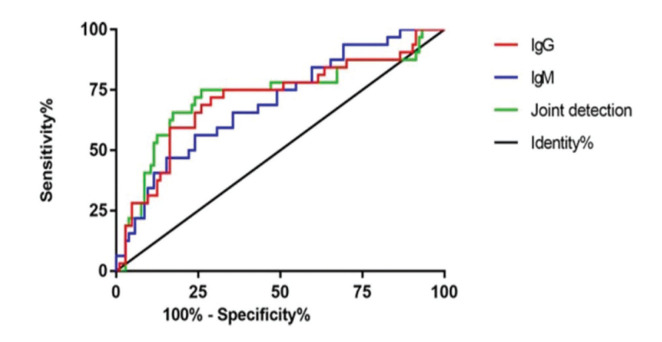
Receiver operating characteristic curves of IgG and IgM. The area under the curve (AUC) of IgG was 0.713; when the specificity was 82.69% and the sensitivity was 59.38%, the optimal cut-off value was 17.458, and the Youden index was 42.07%. The AUC of IgM was 0.696; when the specificity was 75.00% and the sensitivity was 56.25%, the optimal cut-off value was 24.020, and the Youden index was 31.25%. The AUC of the combined detection was 0.727; when the specificity was 74.04% and the sensitivity was 71.88%, the optimal cut-off value was 0.273, and the Youden index was 45.92%.